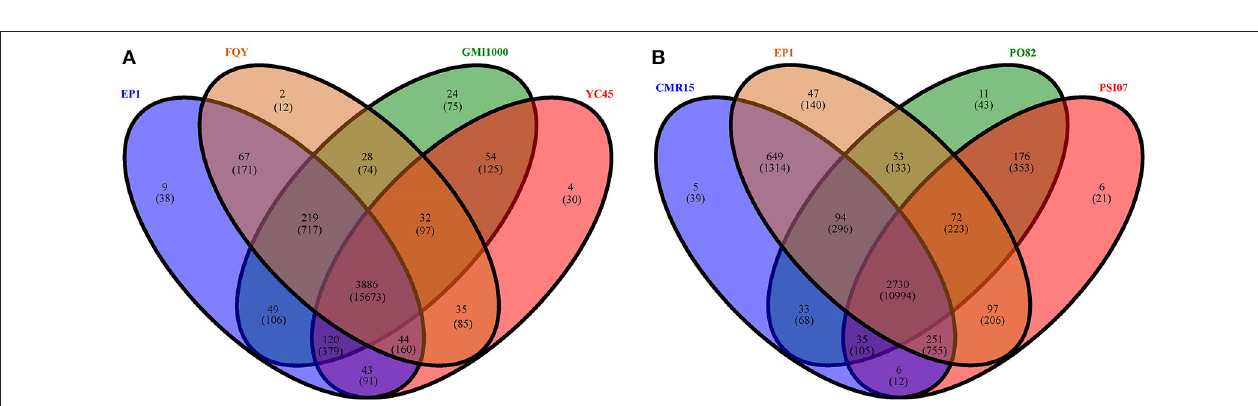
FIGURE 5 | Venn diagrams for deduced proteins of 4 phylotype I species (A), and 4 different phylotype species (B). The overlapping sections indicate shared numbers of deduced proteins. Values were calculated by OrthoMCL cluster analyses with the parameters: P -value Cut-off = 1 × 10 − 5 , Identity Cut-off = 90%, Percent Match Cut-off = 80. The overlapping sections indicate shares numbers of gene families, the numbers in brackets mean the genes of the corresponding gene families.